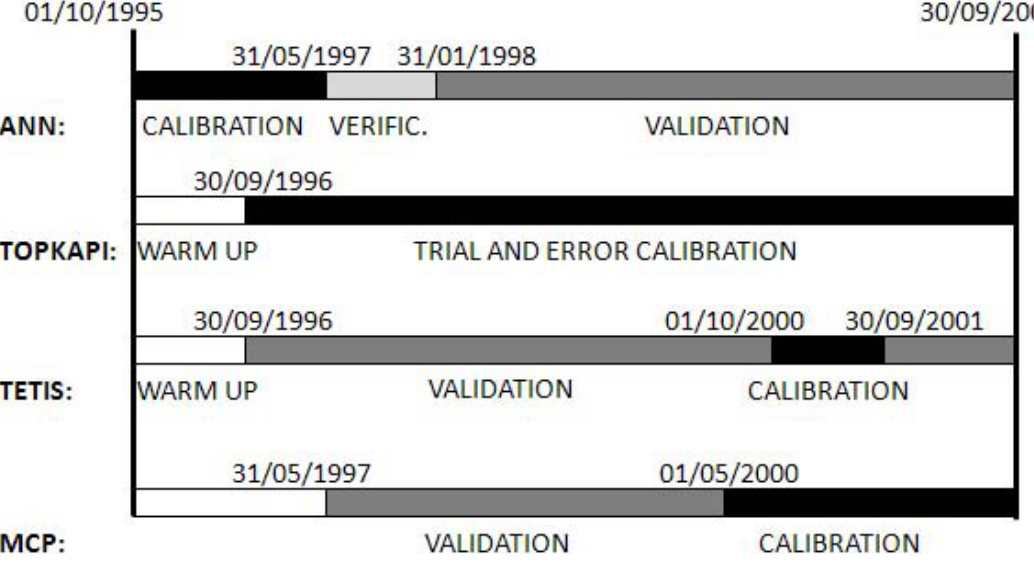
Hydrol. Earth Syst. Sci., 15, 3253–3274, 2011